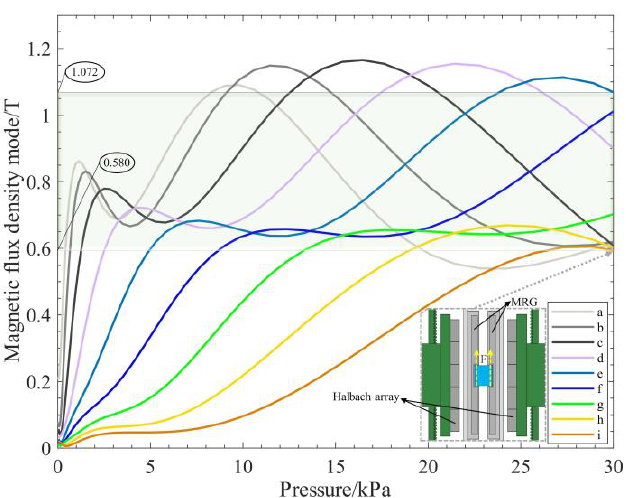
Figure 14. The soft robot input air pressure and the magnetic field strength curve of the MRG layer. Where a, b, c, d, e, f, g, h, i are the measurement points. Inside the dotted line is a schematic diagram of the gripped object, and F is the supporting force at the bottom of the gripped object.